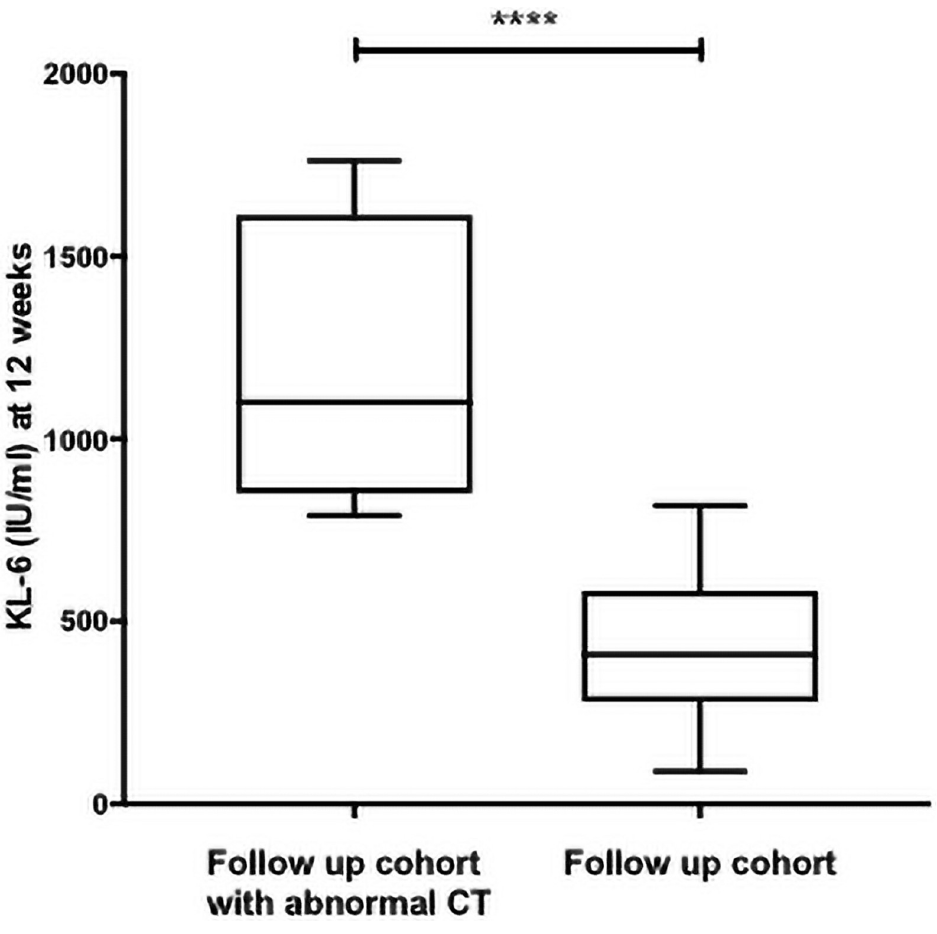
Fig 3. Serum Krebs von den lungen (KL-6) levels in patients with abnormal CT scans at 12 weeks. Patients with abnormal CT scans at 12 weeks had significantly higher convalescent KL-6 levels compared to the remainder of the cohort (median KL-6 1101 IU/ml, n = 4 vs 409 IU/ml, Mann Whitney U, p < 0.0001 ���� ).